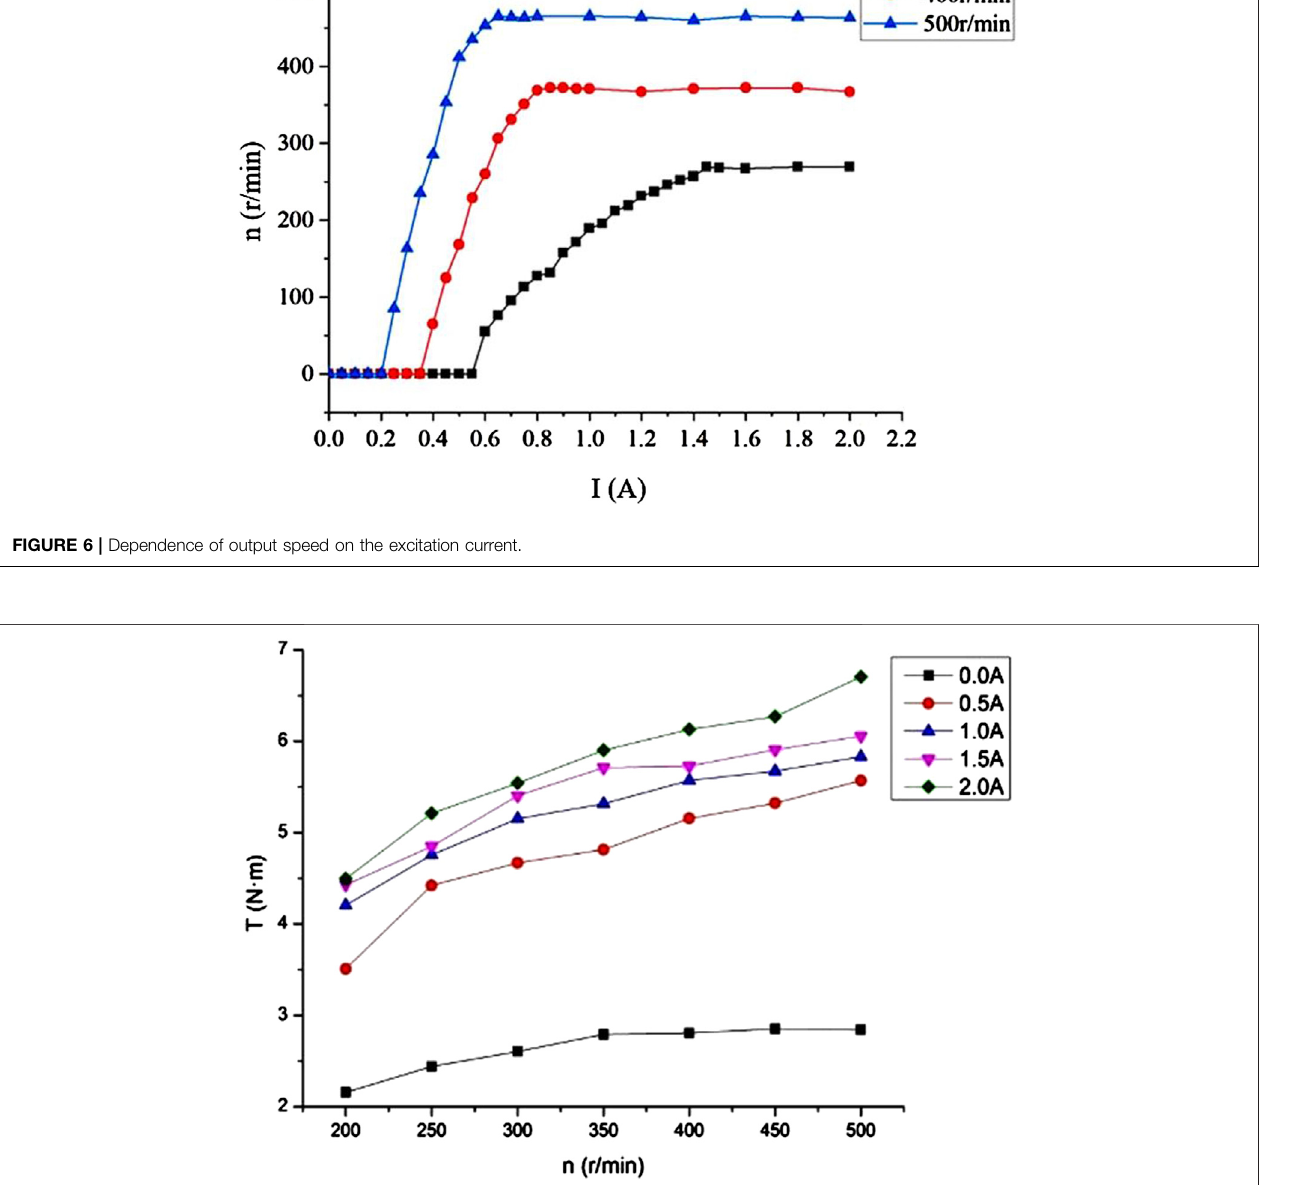
FIGURE 7 | Dependence of torque on the input